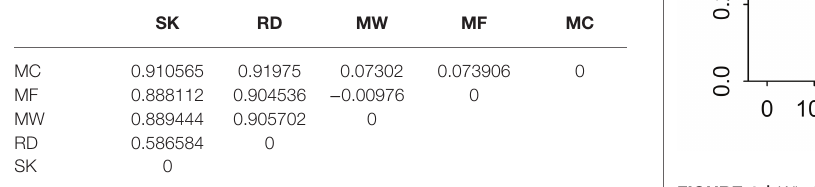
FIGURE 4 | Whole-genome scale patterns of linkage disequilibrium across reintroduced Père David’s deer